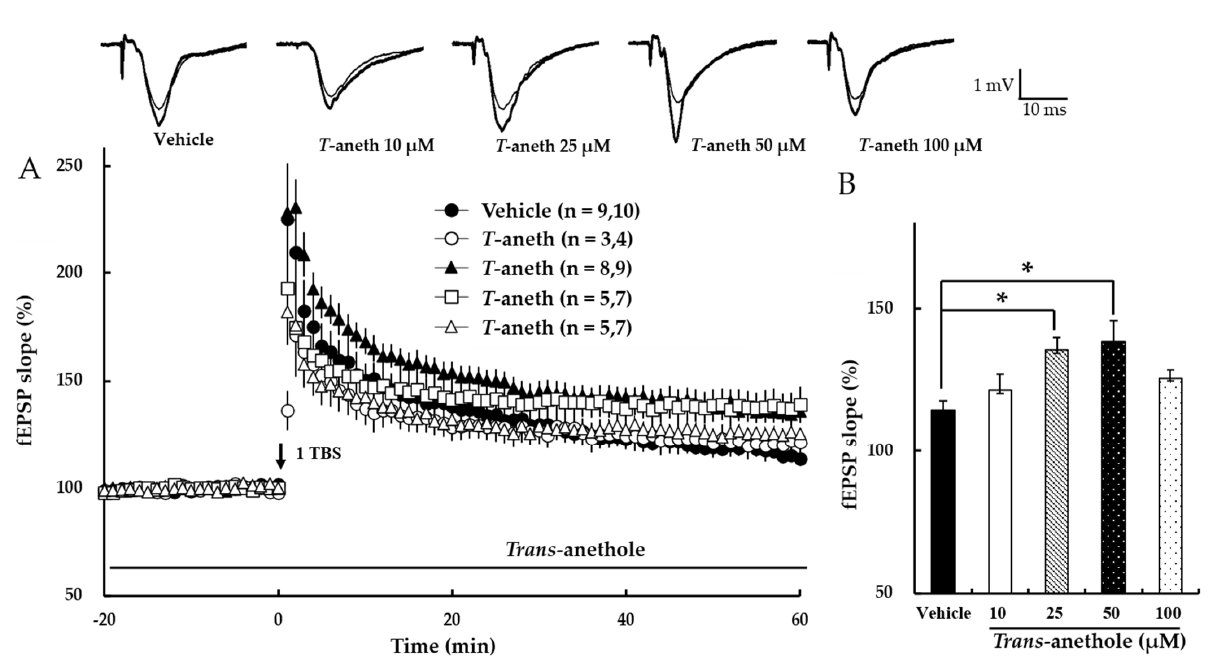
Figure 2. Trans ‐ anethole enhances NMDA receptor ‐ dependent LTP. ( A ) NMDA receptor ‐ dependent LTP was induced by 1 TBS. Trans ‐ anethole was applied during the time period indicated by the bar. The numbers of studied mice and slices, respectively, are presented in parenthesis. The filled circles, open circles, filled triangles, open squares, and open triangles indicate the Vehicle group, 10 μ M Trans ‐ anethole group, 25 μ M Trans ‐ anethole group, 50 μ M Trans ‐ anethole group, and 100 μ M Trans ‐ anethole group, respectively. ( B ) Values represent the percent change observed in the fEPSP slope at 58–60 min after 1 TBS. Statistical significance (* p < 0.05 vs. Vehicle) was calculated by one-way ANOVA followed by Tukey HSD test. Examples of responses recorded 1 min before (thin traces) or 60 min after (thick traces) TBS are shown above. * p < 0.05 vs. the corresponding